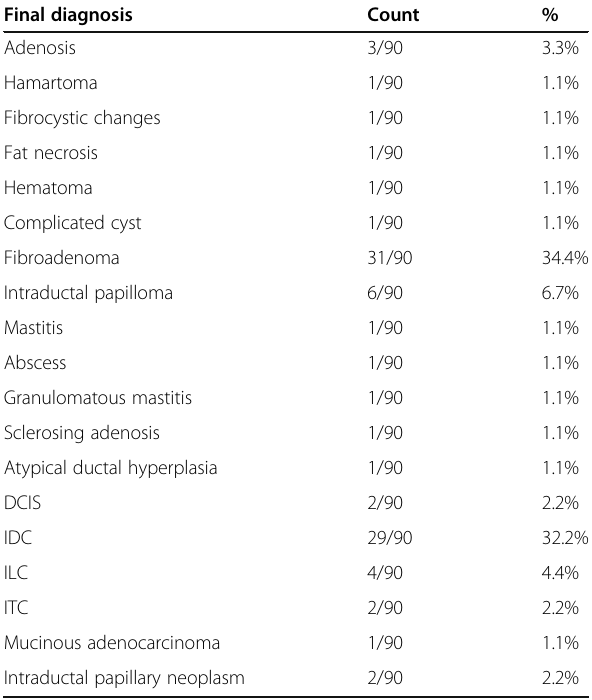
Table 1 Final diagnosis of the studied cases (proven by histopathology or ultrasound findings with routine follow-up for normal and typically benign findings) Final